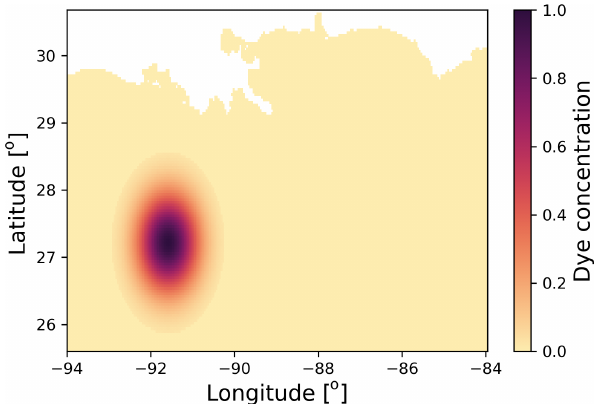
Figure 1. Model domain and initial blob of passive dye at the sur- face for the first set of numerical